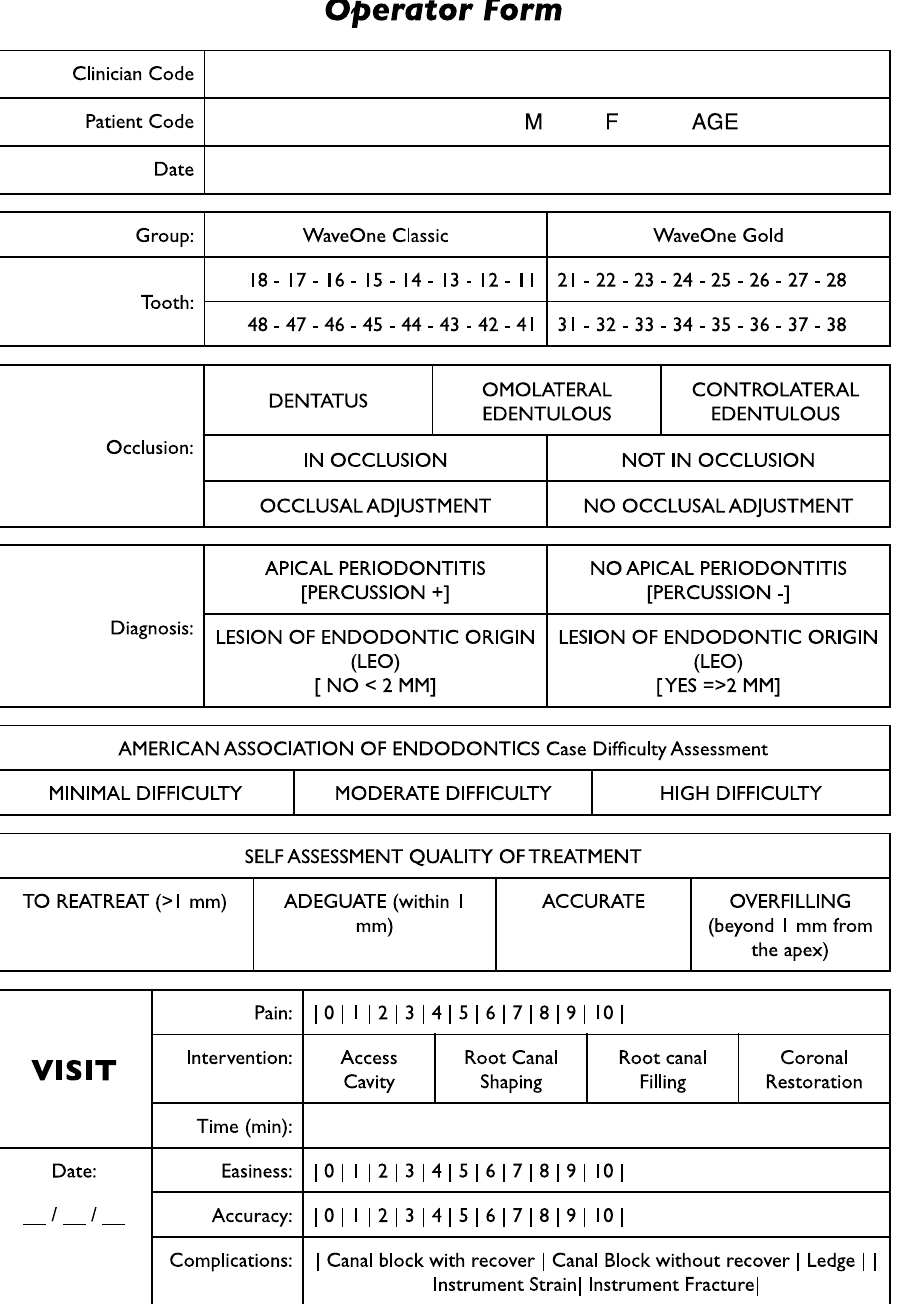
Figure A3. Operator Form.